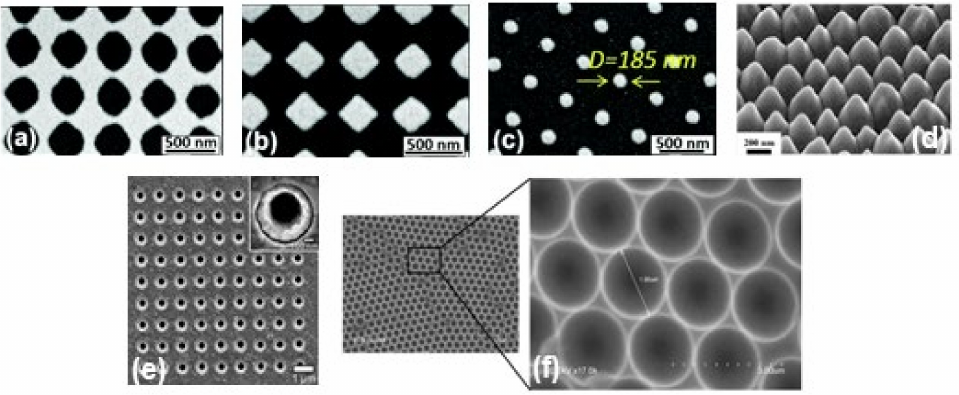
Figure 3. SEM images of metallic periodic nanostructures nanohole arrays ( a ), diamond-shaped nanoparticle arrays ( b ), arrays of cylindrical nanoparticles ( c ) fabricated by different development times 95 s, 110 s, and 165 s, respectively. Reproduced from ref. [73] with permission from the Royal Society of Chemistry. ( d ) 45 ◦ tilt view of nanostructure arrays with Au coating thickness 60 nm. Reproduced with permission from Springer Nature Publications of ref. [49]. ( e ) nanohole array with 500 nm diameter, the inset shows the magnified image of one of the holes. Reprinted (adapted) with permission from ref. [70], Copyright 2010 American Chemical Society. ( f ) the cavity array substrate of 2 µ m fabricated applying polystyrene microsphere template approach